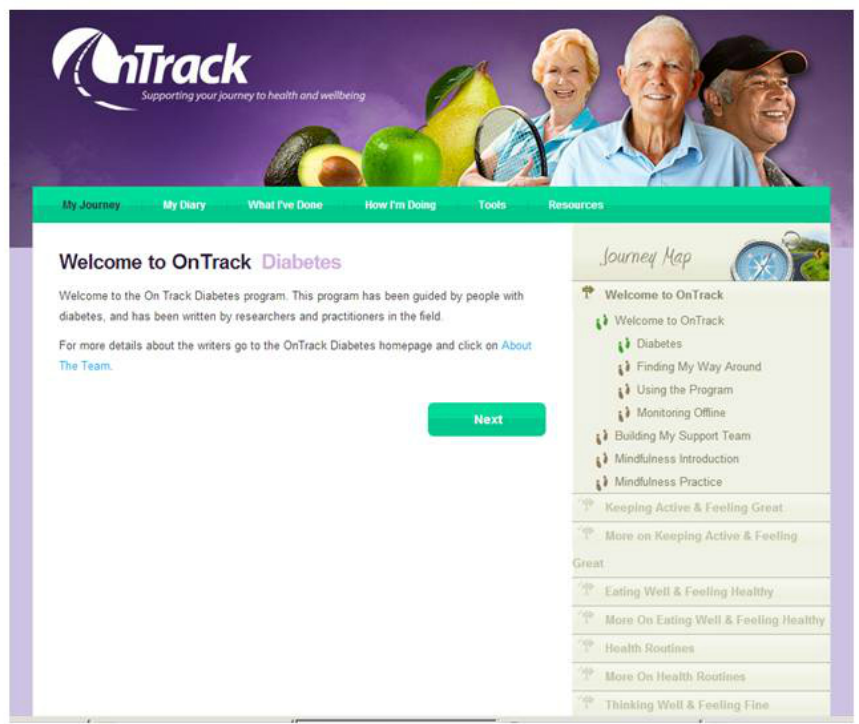
Figure 2. Screenshot of the OnTrack Diabetes program